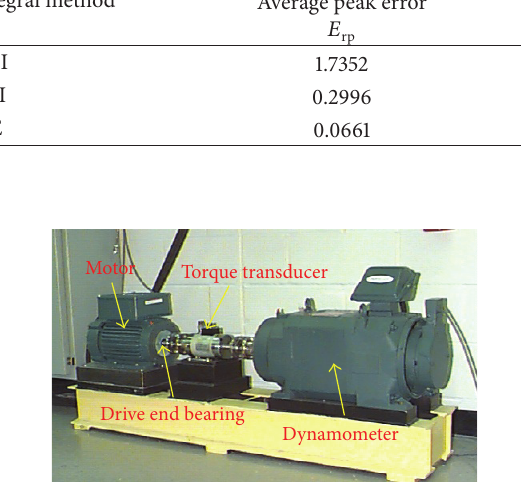
Figure 6: Fault test bench of rolling bearing.